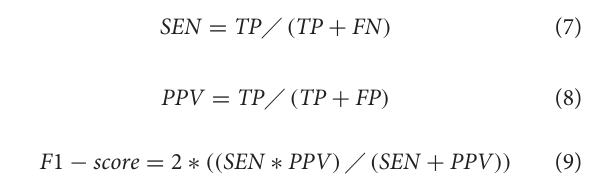
Table 3 . TP was the number of base pairing positions in the